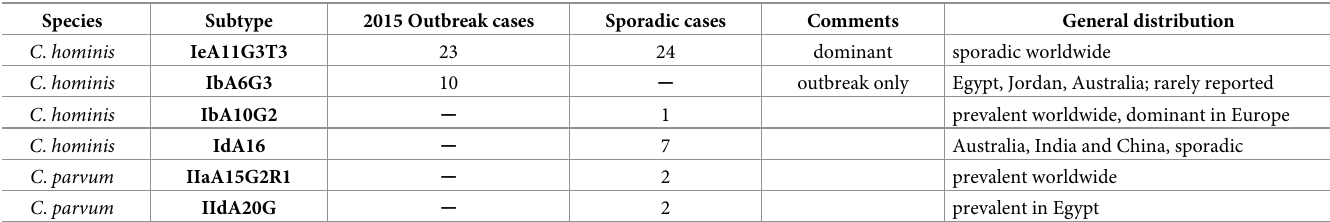
Table 1. Cryptosporidium